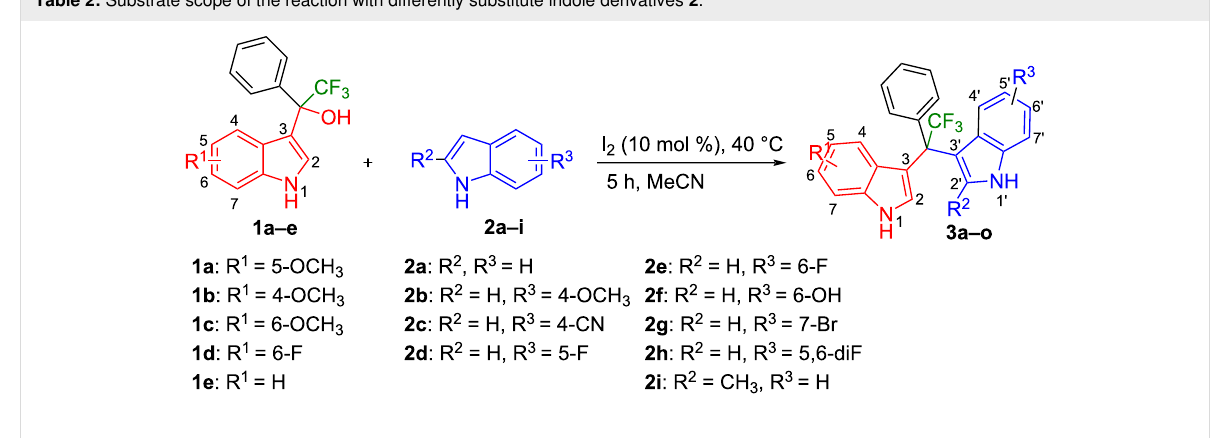
Table 2: Substrate scope of the reaction with differently substitute indole derivatives 2 .